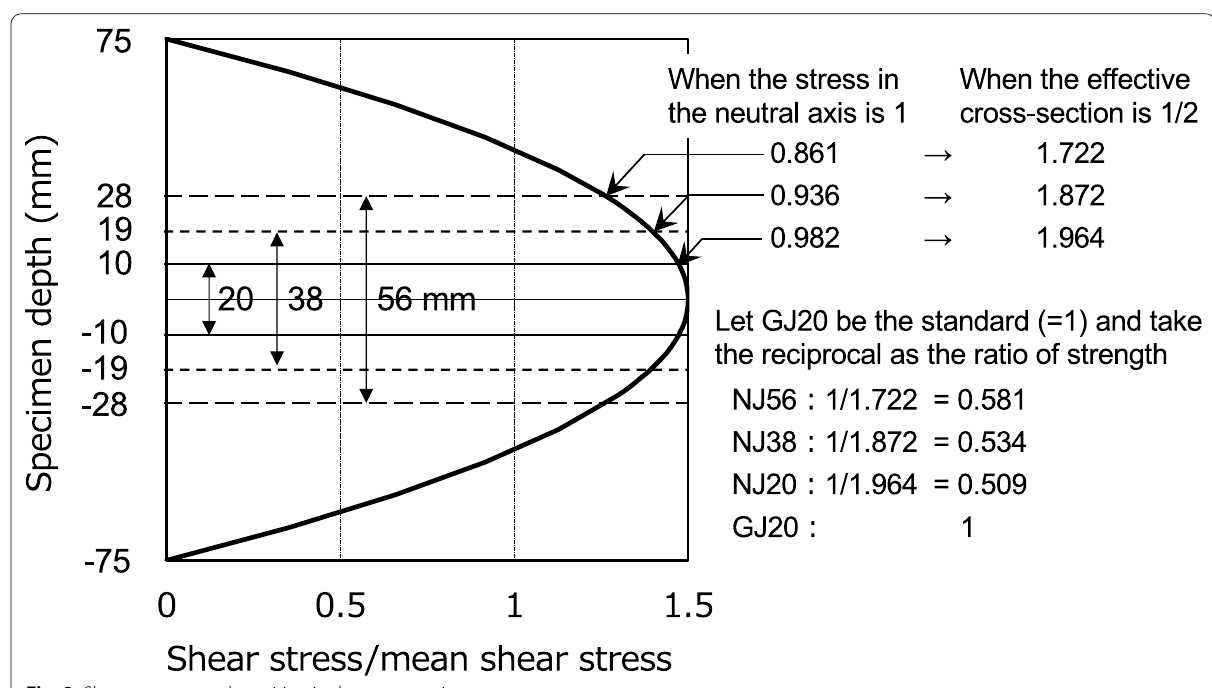
Fig. 8 Shear stress at each position in the